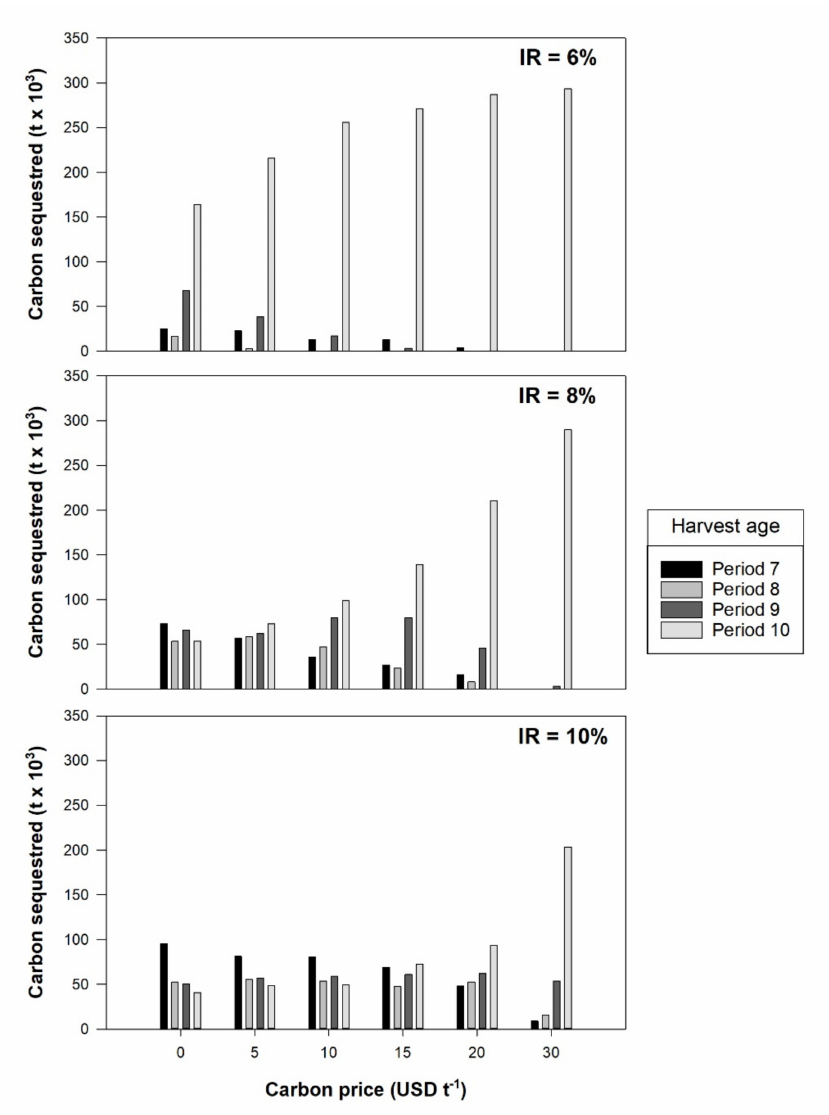
Figure 5. C sequestered and accumulated until harvest age by C price and interest rate